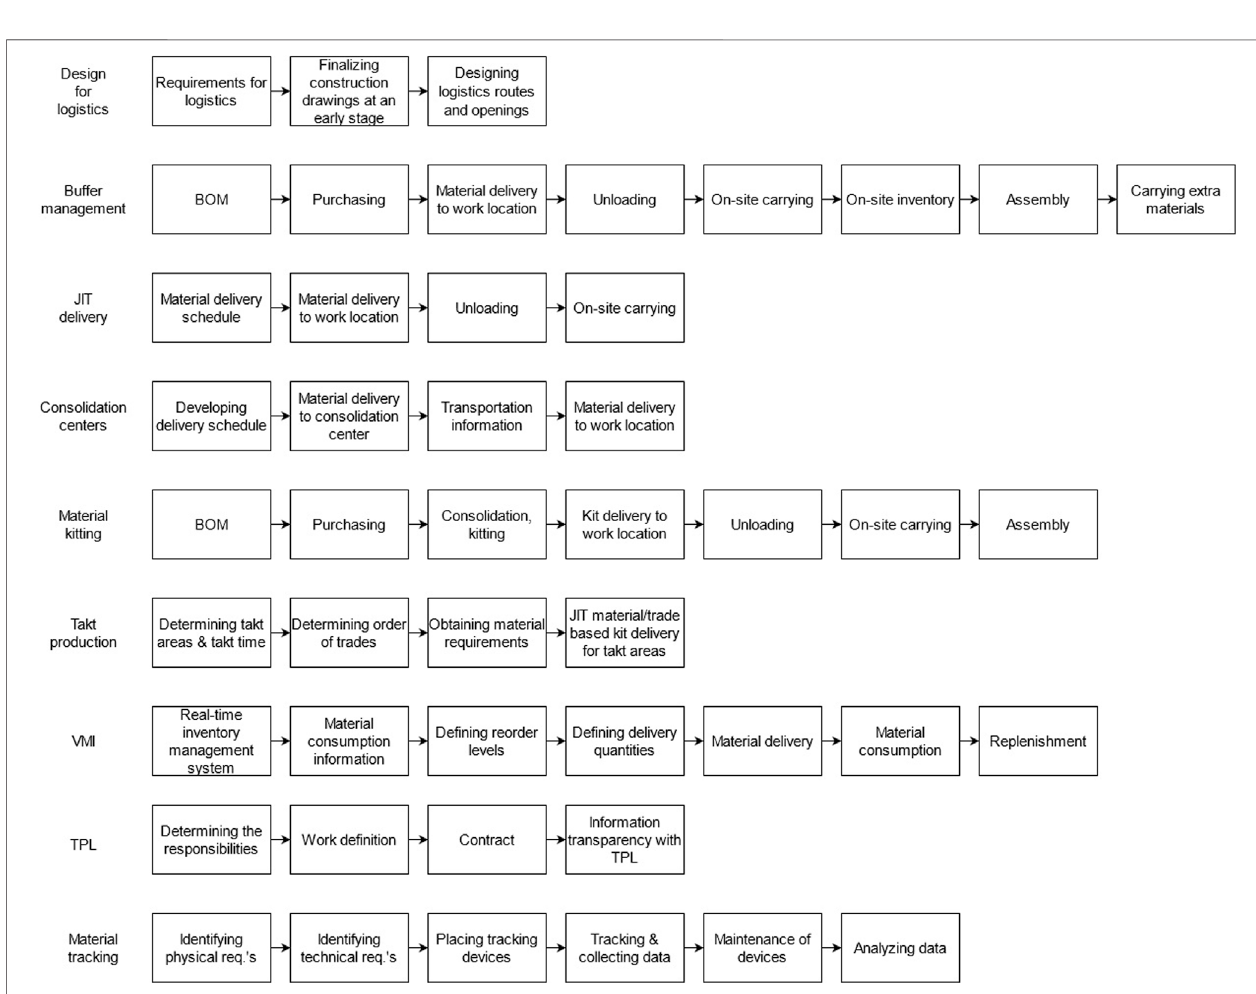
FIGURE 1 | Key steps for implementing logistics solutions in construction.